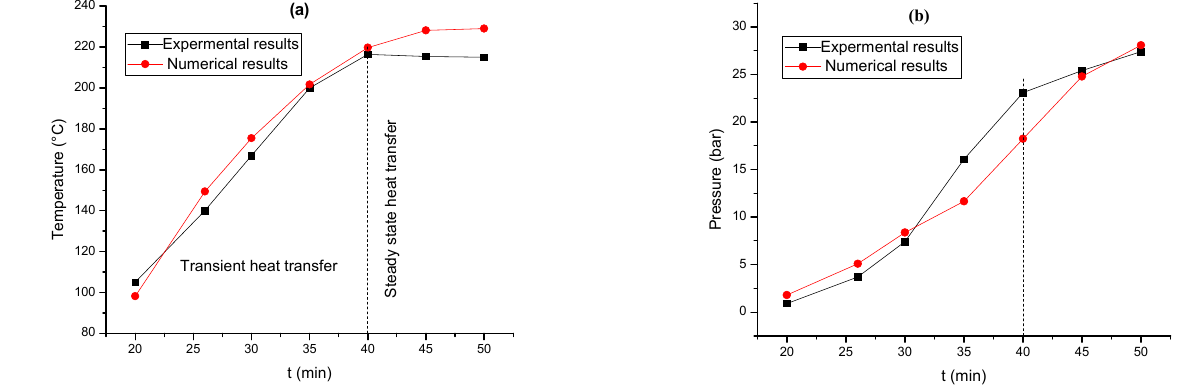
Figure 4. Comparison between experimental and simulation results inside the reactor: ( a ) temperature and ( b ) pressure.